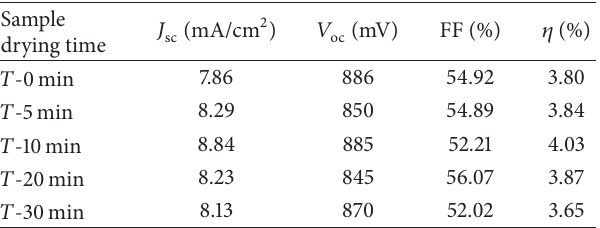
Table 2: Experiment average parameters and sample calibration of different drying